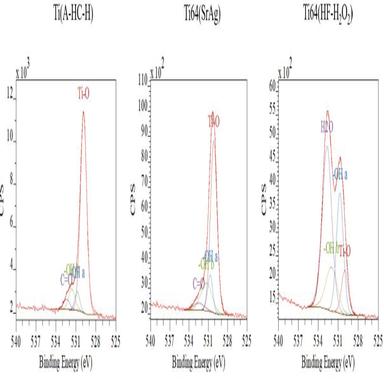
Deconvolution of the O1s region for the treated titanium samples.